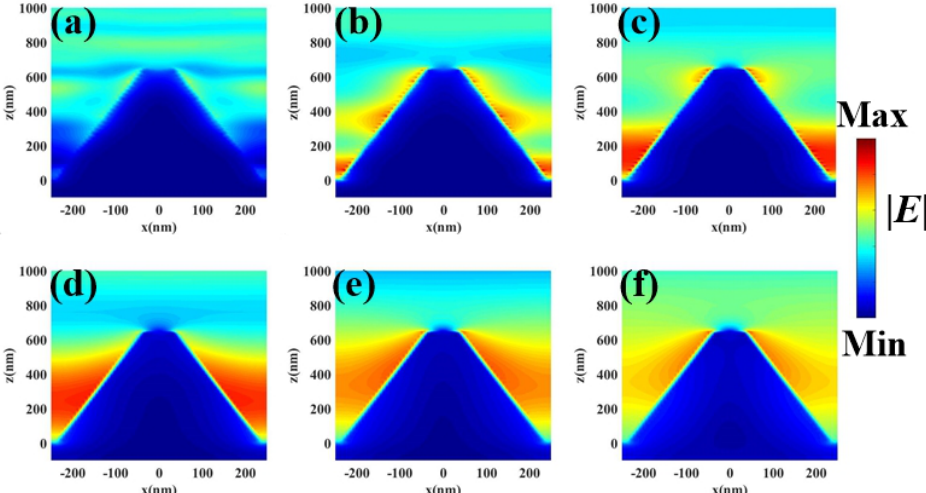
Figure 3. In the x–z plane, the electric field |E| distribution at wavelengths of ( a ) 254 nm, ( b ) 590 nm,